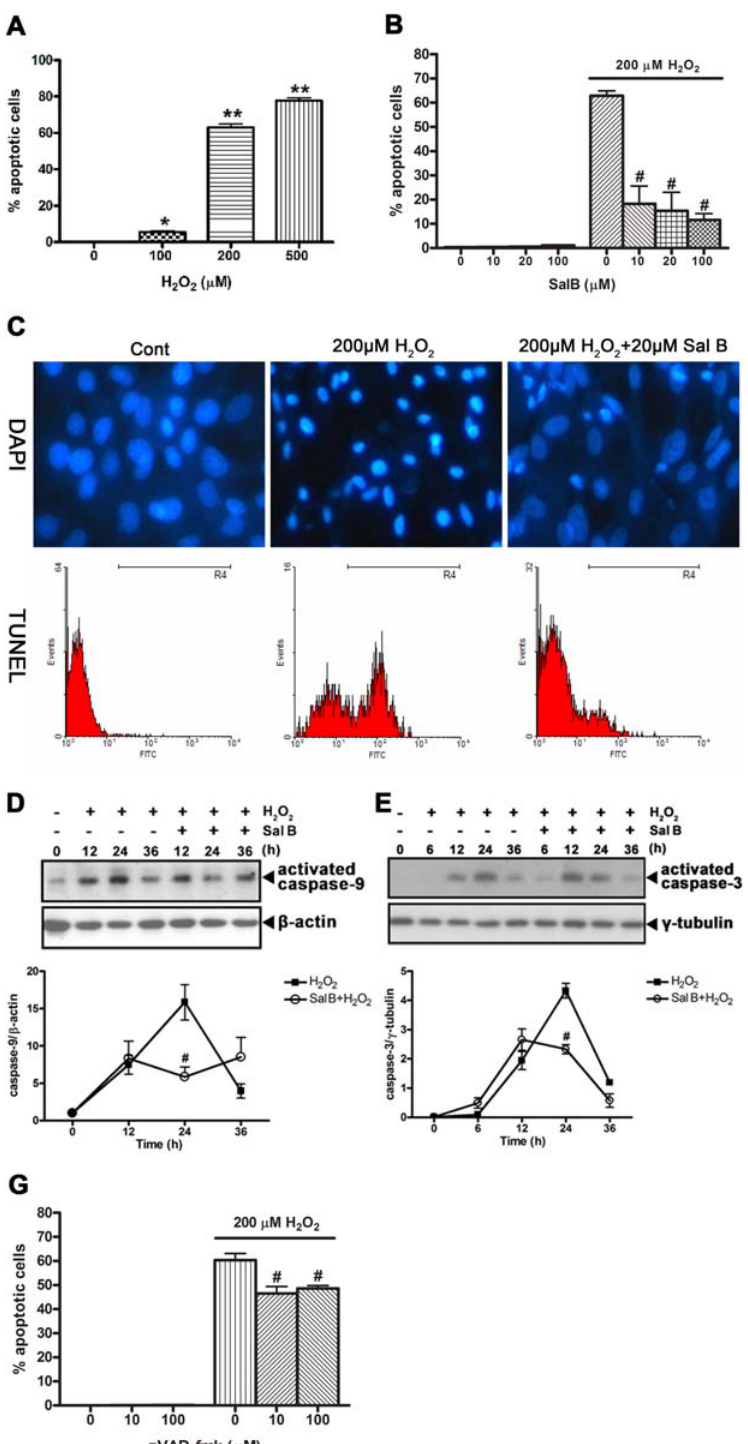
Figure 1. Inhibition of H 2 O 2 -induced rCMECs apoptosis by Sal B. (A) Apoptosis was induced in rCMECs with 0 , 500 m M H 2 O 2 for 12 h and determined by TUNEL assay. (B) rCMECs were pretreated with Sal B (0 , 100 m M) for 30 min, and then coincubated with or without 200 m M H 2 O 2 for 12 h, followed by apoptosis measurement using TUNEL assay. (C) rCMECs were analyzed by DAPI staining and TUNEL assay after a 12-h exposure to H 2 O 2 with or without Sal B pretreatment. (D) Time course of caspase-9 activation in rCMECs incubated with H 2 O 2 (200 m M) alone or with H 2 O 2 (200 m M) and Sal B (20 m M). (E) Time course of caspase-3 activation in rCMECs incubated with H 2 O 2 (200 m M) alone or with H 2 O 2 (200 m M) and Sal B (20 m M). Immunoblotting were carried out on cell lysate proteins from control cells or rCMECs pretreated with Sal B for 1 h and then exposed to H 2 O 2 for the indicated times. (G) rCMECs were pretreated with zVAD-fmk (0 , 100 m M) for 60 min, and then coincubated with or without 200 m M H 2 O 2 for 12 h, followed by apoptosis measurement using TUNEL assay. * P , 0.05; ** P , 0.01 versus control, # , P , 0.05 versus H 2 O 2 alone. Data are representative of three independent